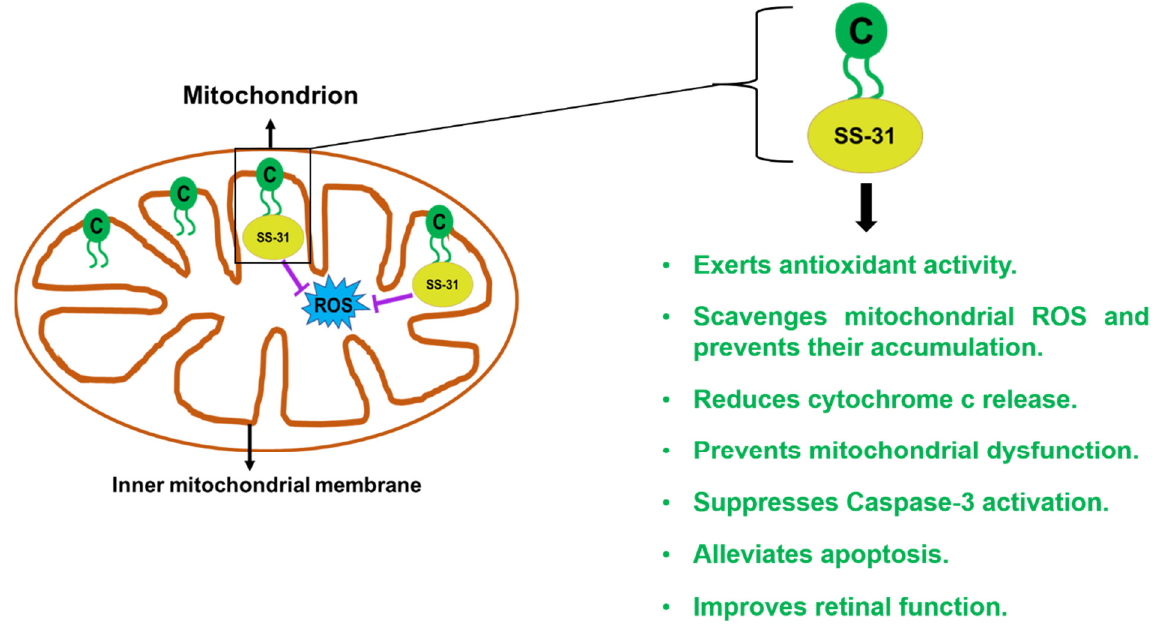
Figure 6. SS-31/Elamipretide’s mechanism of action. SS-31 exerts its protective effects by binding to Cardiolipin on the inner mitochondrial membrane. SS-31 bound to Cardiolipin prevents the accumulation of ROS, exerts antioxidant effects, reduces apoptosis, prevents mitochondrial dysfunction, and promotes retinal function.